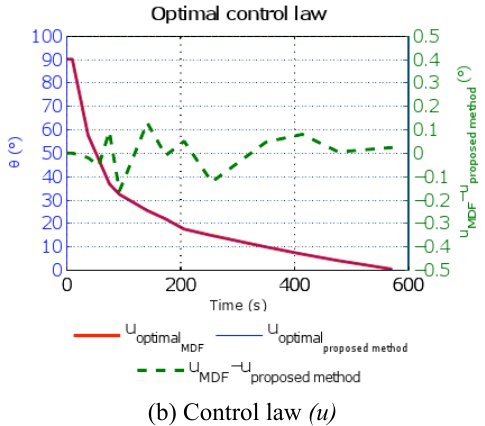
Fig. 7. Trajectory of the optimal design